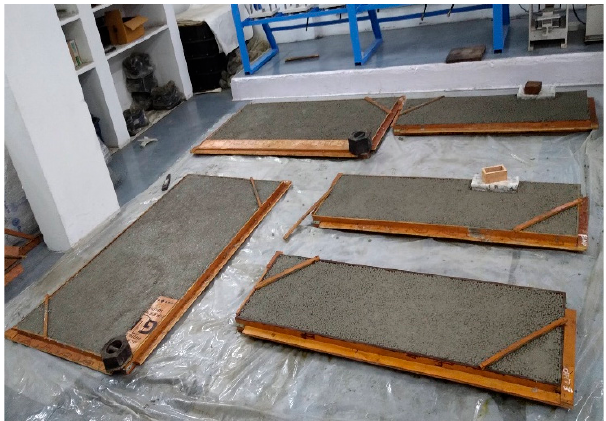
Figure 12. Casting of prefabricated panels.